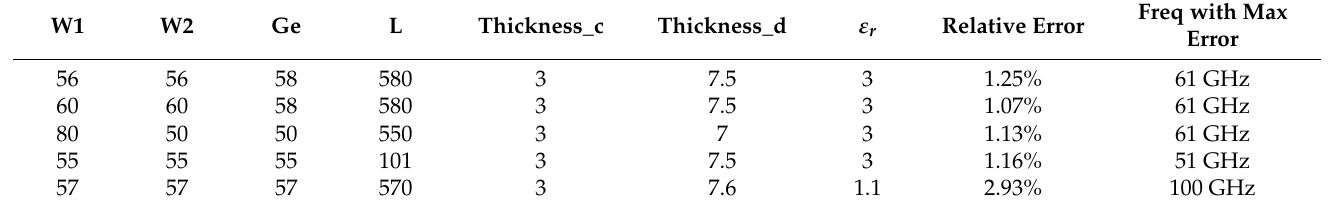
Table 14. Testing data of coupled transmission lines.